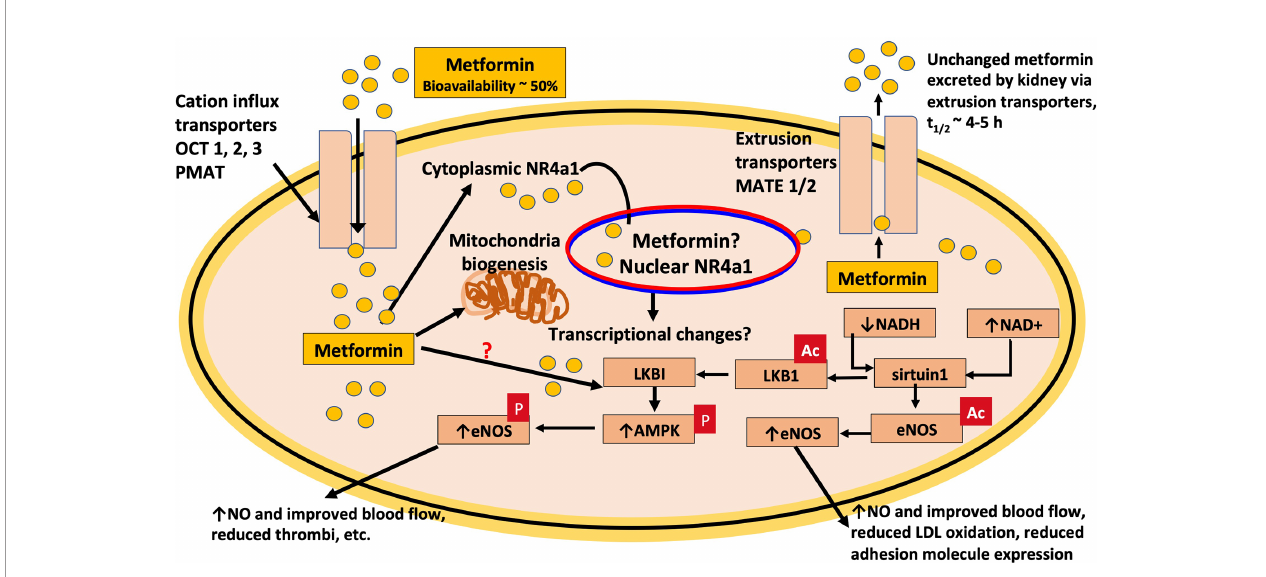
FIGURE 2 | Metformin protects endothelial function. Pre-clinical and clinical data indicates that metformin has direct effects to protect the endothelium from diabetes-induced dysfunction and treatment results in improved function of endothelial nitric oxide synthase (eNOS), the generation of nitric oxide (NO) and improved blood fl ow that facilitates glucose disposal. Based on in vitro data, the effects of metformin are dependent on the expression of the NAD+ dependent deacetylase, sirtuin1, which targets lysine residues on eNOS as re fl ected in the fi gure by removal of ac, the activation of AMPK, and the nuclear orphan receptor, NR4A1. The latter has important links to the regulation of metabolism. OCT3 transporter expression in nuclear membrane facilitates metformin transport into the nucleus